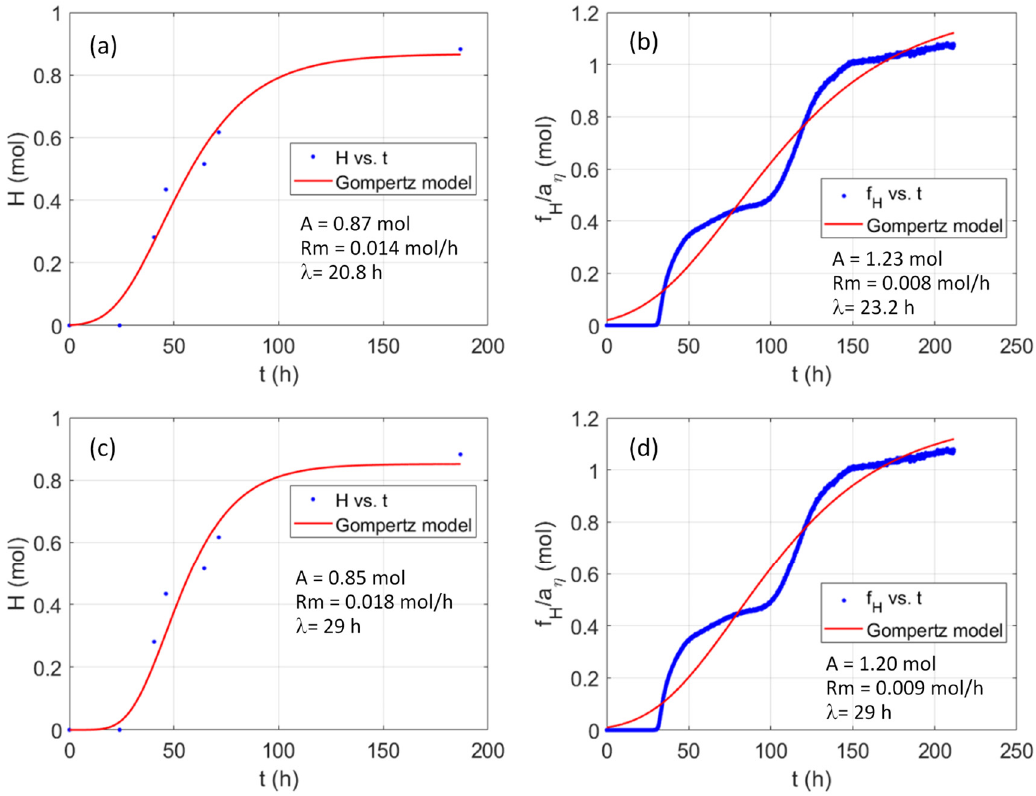
Figure 6. Comparison of the measured moles of H 2 in batch V ( a , c ) and the moles of hydrogen estimated from the corresponding pH curve using the function f H and the relation given by Equation (13) ( b , d ) vs. the values predicted by the modified Gompertz model with three fitted parameters ( a , b ) or two fitted parameters and the lag phase time estimated from the pH curve, as described before ( c , d ).